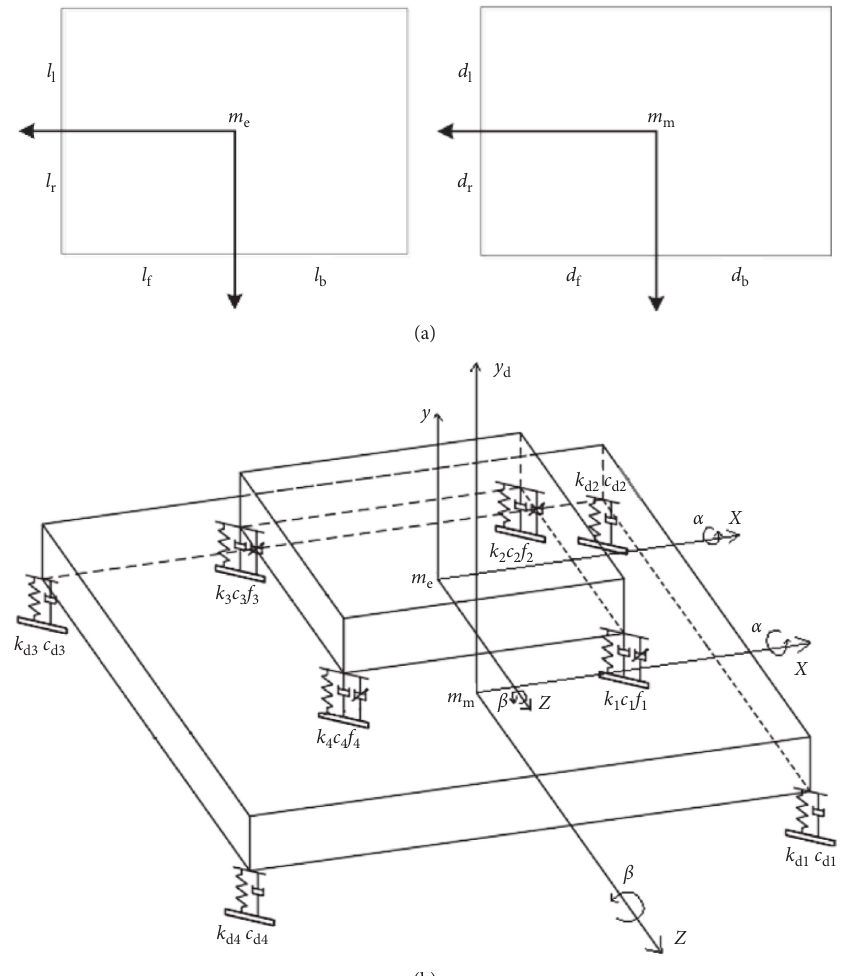
Figure 8: Dynamic model of the semiactive isolation